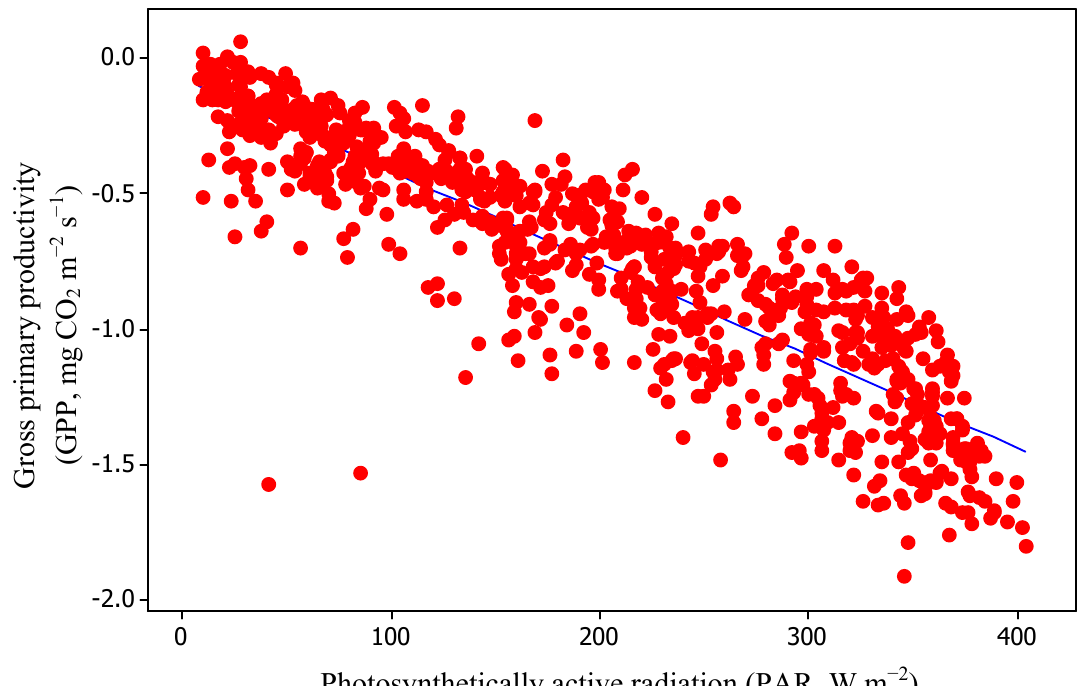
Figure 14. Quantification of relationship between PAR and GPP based on Equation (6) for the Yenicaga peatland ( R 2 = 80.3%; SE = 0.1929; n = 896; P < 0.001). adj